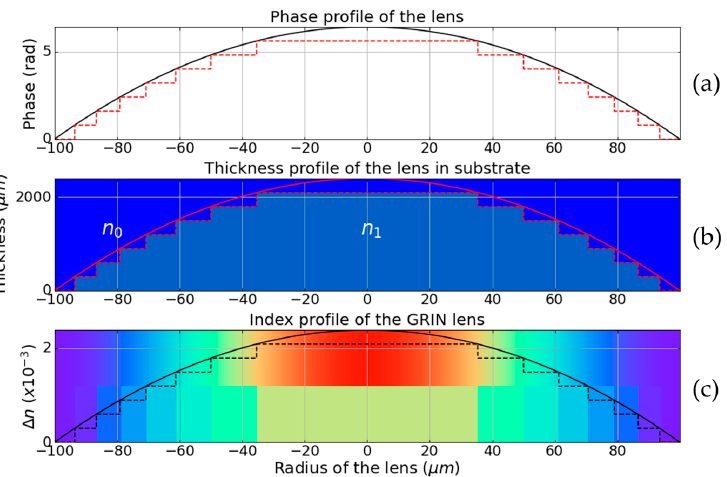
Figure 5. ( a ) GRIN lens phase profile. In black, the continuous phase profile, and in red, the discrete phase profile. ( b ) Thickness profile of a gradient thickness lens and its discretization corresponding to the phase profile presented in ( a ). ( c ) Refractive index profile of a gradient index lens and its discretization corresponding to the phase profile presented in ( a ). The color variation represents the radial refractive index variation.